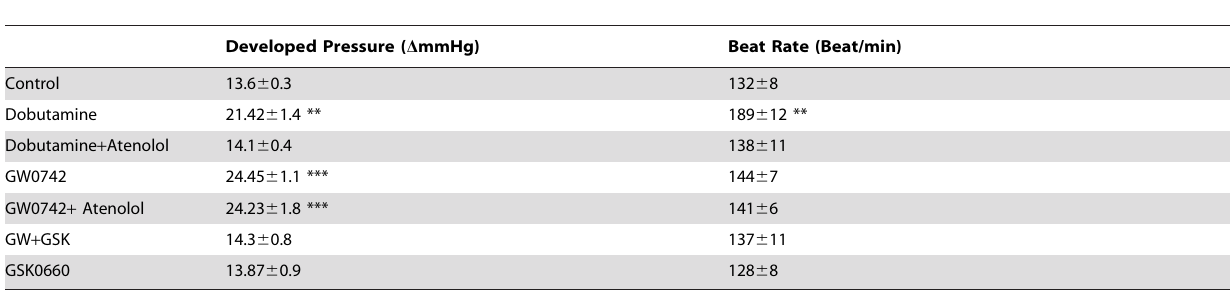
Table 2. Changes of Developed Pressure and Beat Rate in isolated Rat